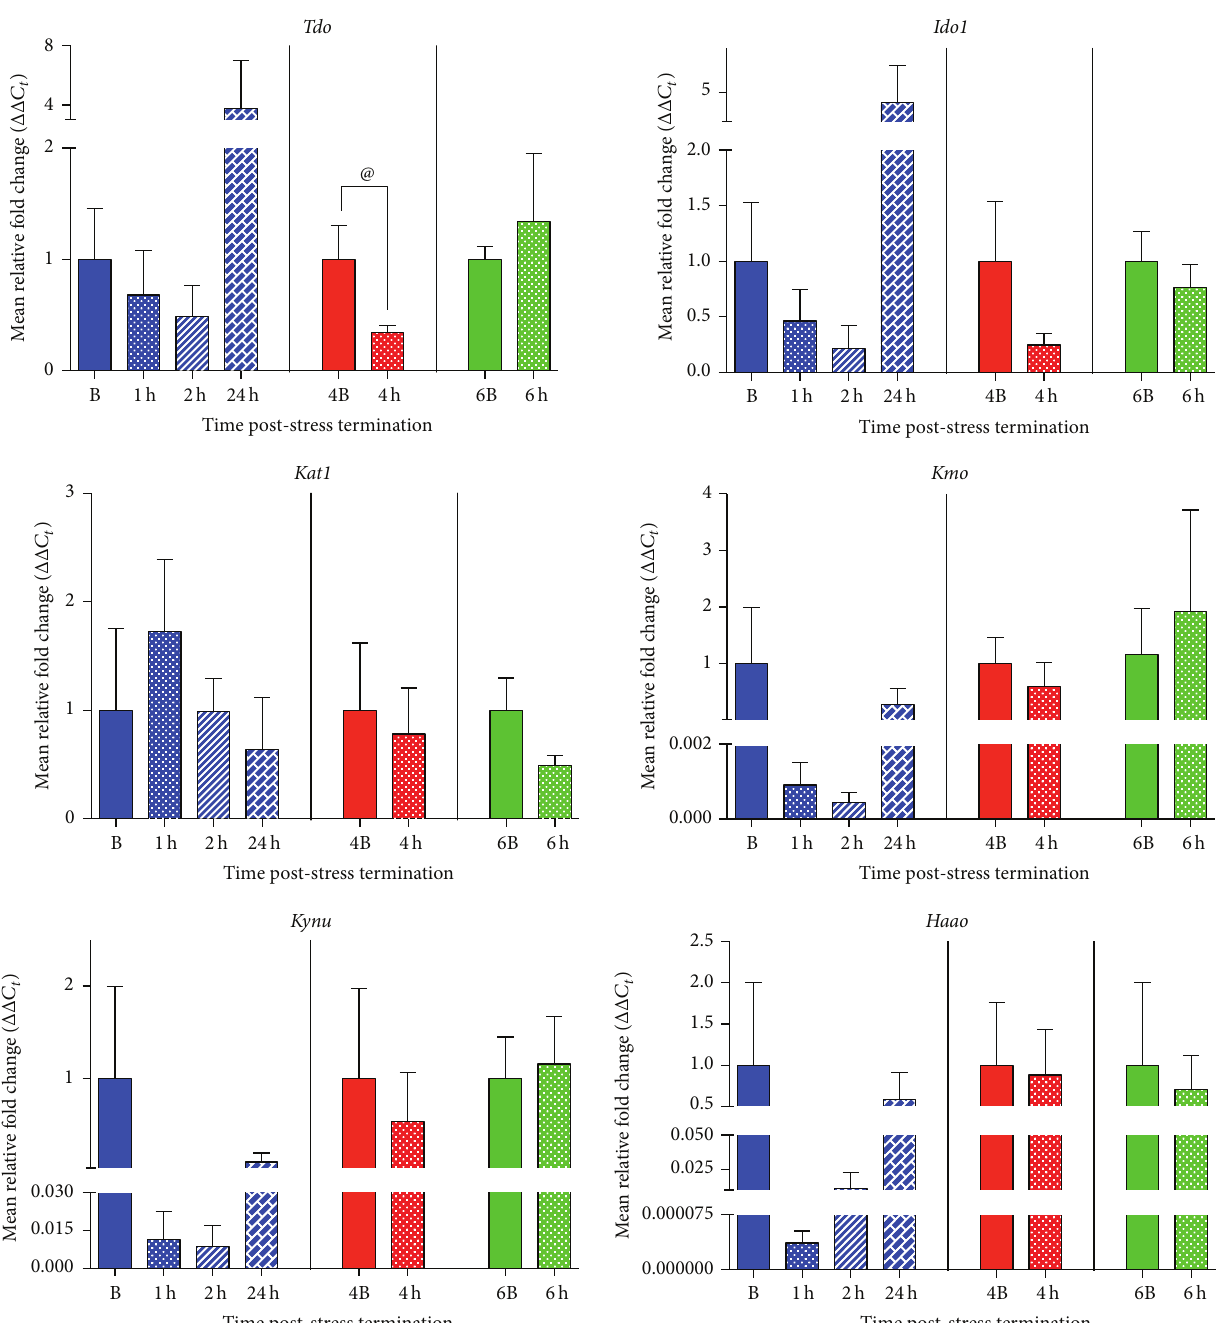
Figure 3: Effects of acute restraint stress on enzymes regulating the kynurenine pathway in the hippocampus. mRNA expression levels of tryptophan 2,3-dioxygenase ( Tdo ), indoleamine 2,3-dioxygenase 1 ( Ido1 ), kynurenine aminotransferase ( Kat1 ), kynurenine 3-monooxygenase ( Kmo ), kynureninase ( Kynu ), and 3-hydroxyanthranilate 3,4-dioxygenase ( Haao ) were examined 1–24 h post-stress termination. All data are represented as means ± SEM (𝑛 = 3 – 6/ group ) . @ 𝑝 < 0.10 (in comparison to the 4B group). 𝑡(7) = 0.31 , 𝑝 = 0.77 , and 𝑅 2 = 0.01 ; 𝑡(8) = 0.65 , 𝑝 = 0.54 , and 𝑅 2 = 0.05) , Kmo (𝐹(3, 20) = 1.10 , 𝑝 = 0.37 , and 𝑅 2 = 0.14 ; 𝑡(10) = 0.09 , 𝑝 = 0.93 , and 𝑅 2 = 0.0009 ; 𝑡(10) = 0.11 , 𝑝 = 0.91 , and 𝑅 2 = 0.001) , or Kynu (𝐹(3, 19) = 0.92 , 𝑝 = 0.45 , and 𝑅 2 = 0.13) ; 4 h (𝑡(10) = 0.86 , 𝑝 = 0.41 , and 𝑅 2 = 0.07) ; 6 h (𝑡(9) = 1.03 , 𝑝 = 0.33 , and 𝑅 2 = 0.10)